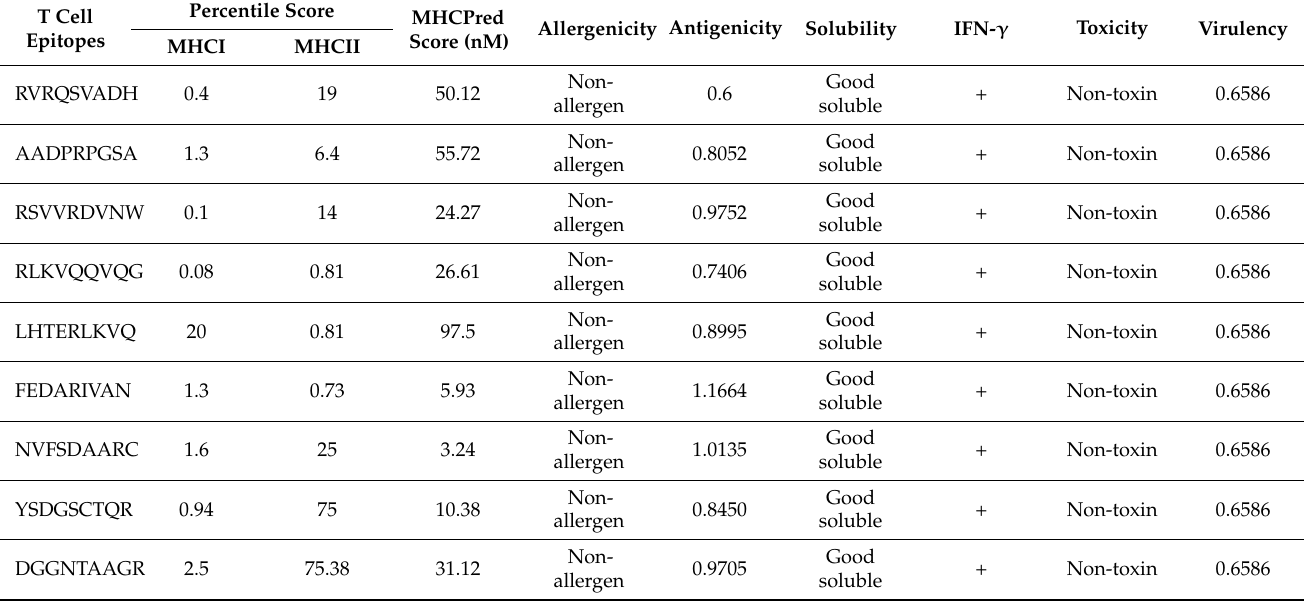
Table 2. The filtered antigenic T-cell epitopes predicted for multi subunit peptide vaccine